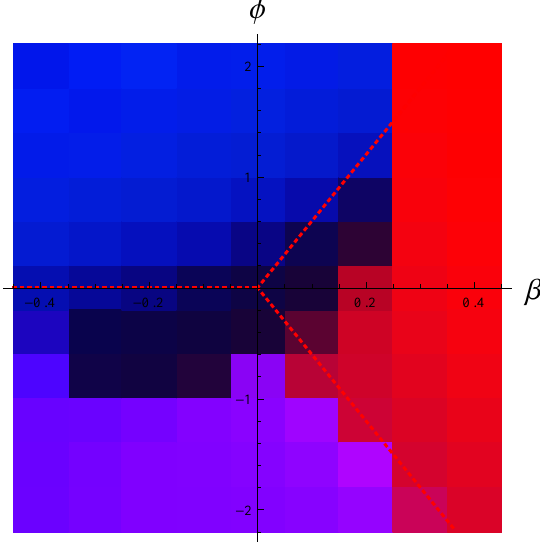
Figure 12: (Color online) Phase diagram on a 8 3 lattice using the “no-touching” vertex resolution protocol. The same color coding system has been used as for the branch point colorplot in Figure 9. The following phases from Table 1 are realized: top (blue): plumber’s nightmare II, right (red): ferromagnetic, and bottom (purple): dilute. The “classical” phase boundaries – i.e. arising purely from minimizing the Hamiltonian – have been indicated with red dotted lines. This is topologically the same as the mean-field phase diagram in Figure 7 but the phase boundaries have shifted